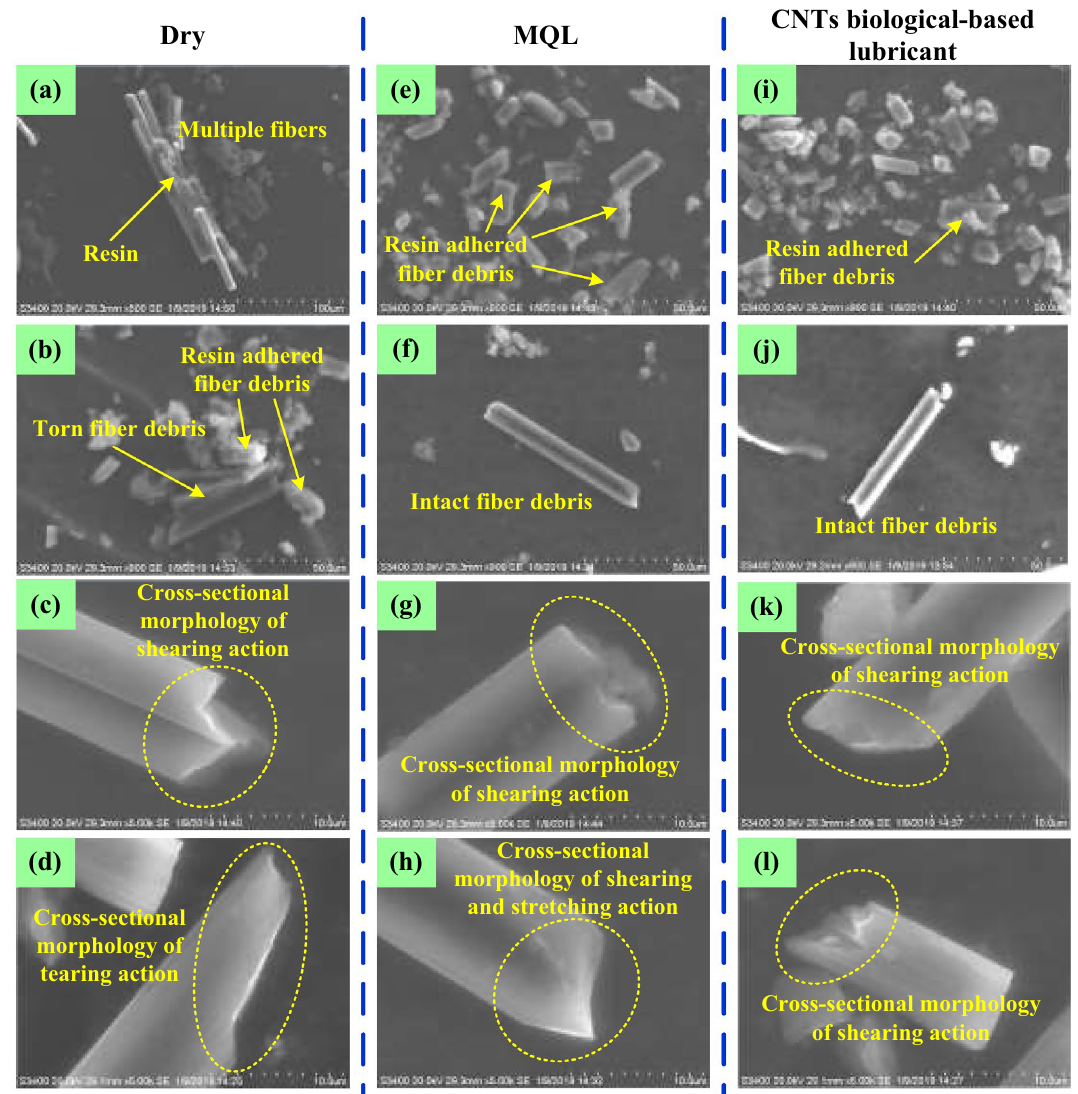
Figure 4. Morphology of grinding debris under different lubrication conditions. Figures were created using the Microsoft Visio sofware (version